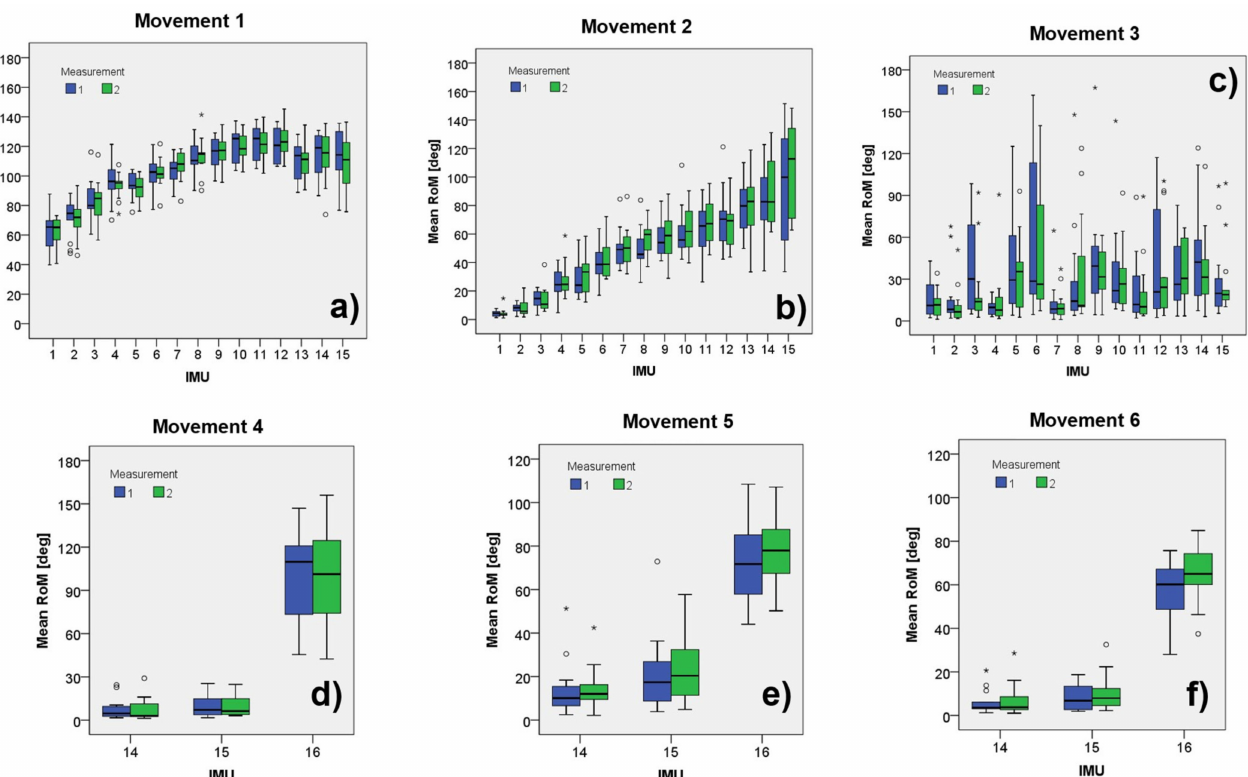
Figure 5. Box plots showing the distribution of the observed RoM with the different MIMUs placed along the subjects’ back and head for the six movements: ( a ) anterior hip flexions; ( b ) trunk lateral flexions; ( c ) trunk axial rotations; ( d ) cervical axial rotation; ( e ) cervical flexion/extension; ( f ) cervical lateral flexions. The blue bars correspond to the first series of measurements, while the green ones correspond to the second series of measures, * and ◦ indicate observed outliers. Table 3. Overall intraclass correlation analysis to assess the repeatability of the system for the six considered movements.